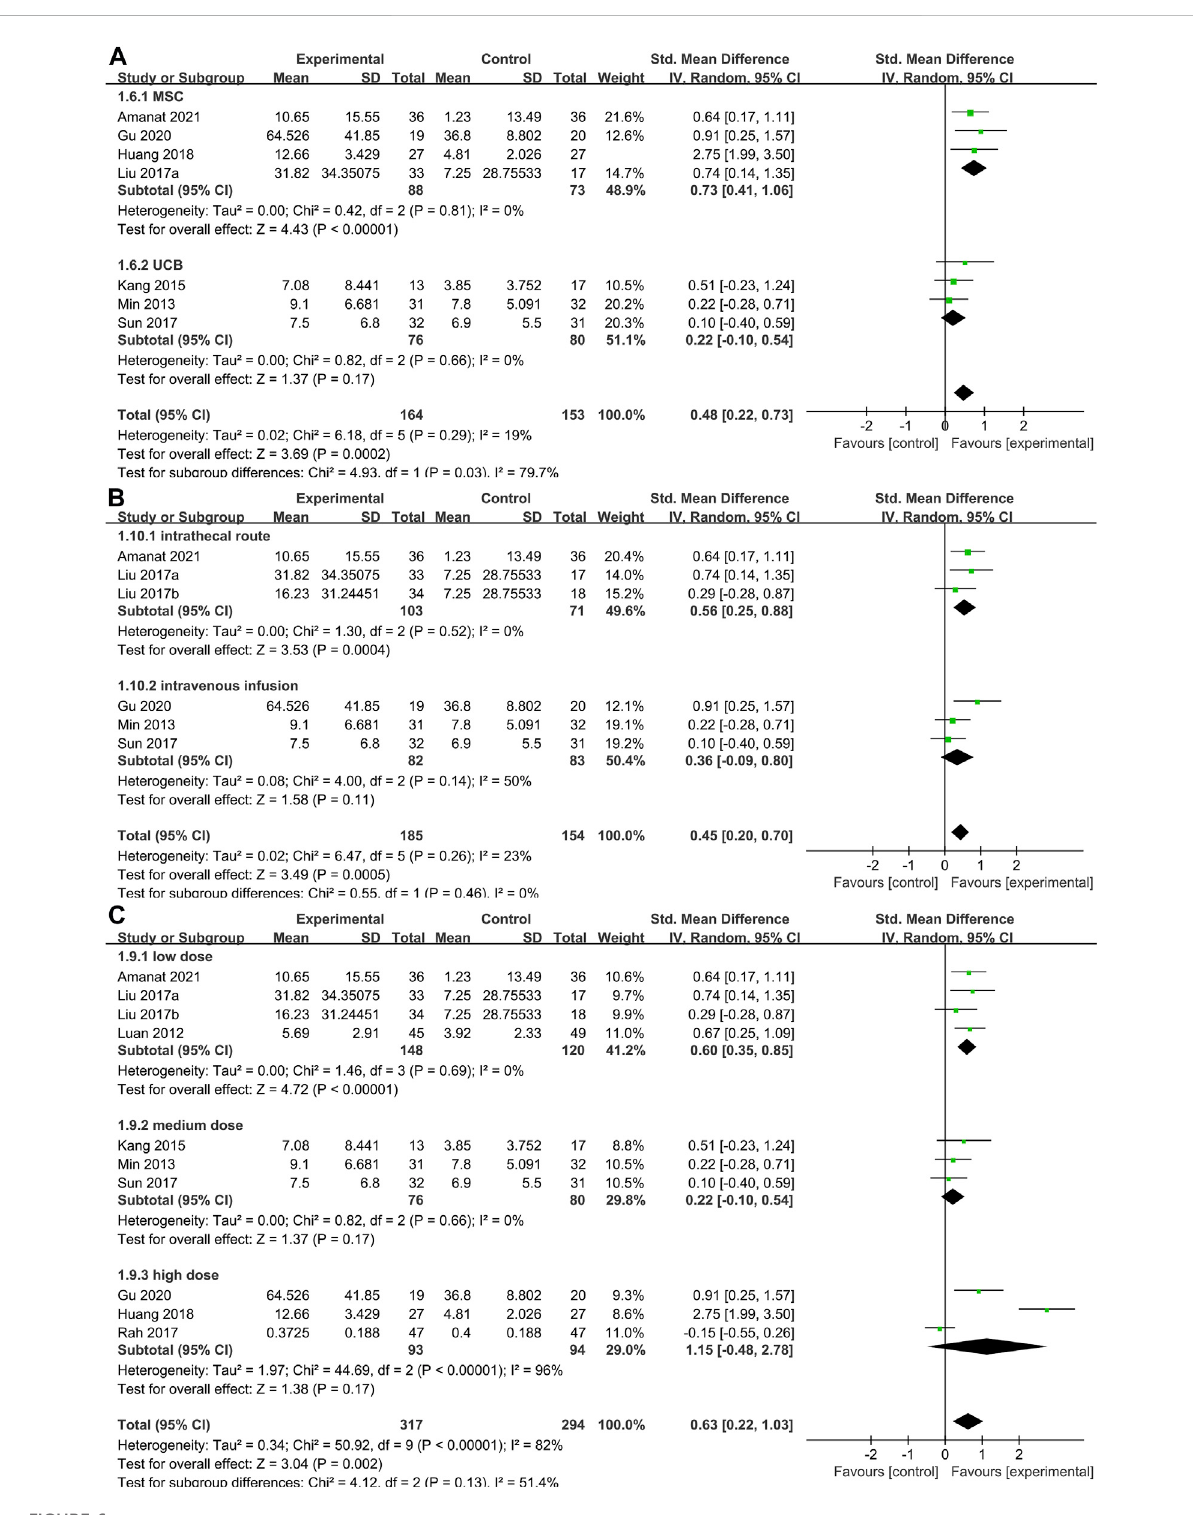
ForestplotofsubgroupinGMFM.Forestplotdemonstratingtheeffectofstemcellscomparedwithcontrolsinsubgroupof (A) stemcellstypes, (B) administration route and (C)